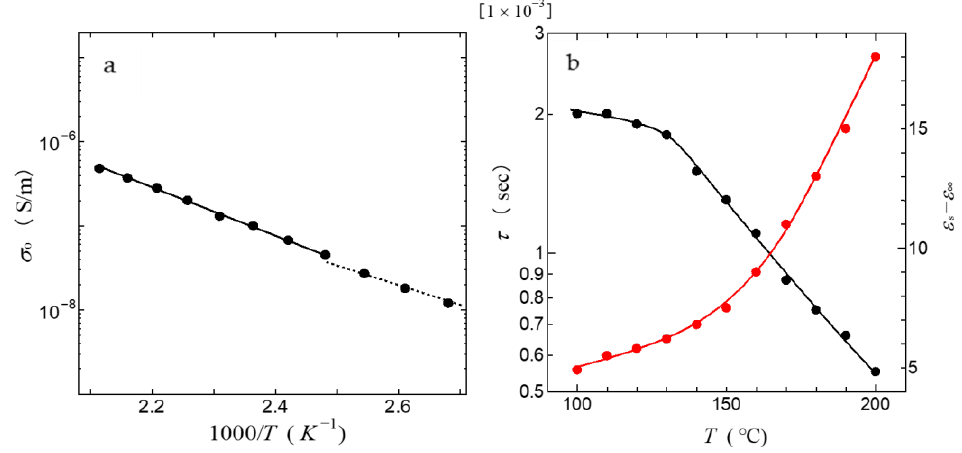
Figure 8. Date fitting of the HAp-collagen composite film. ( a ) Arrhenius plot of proton conductivity in the HAp-collagen composite film. ( b ) Temperature dependence of ε s - ε ∞ and τ in the HAp-collagen composite film.